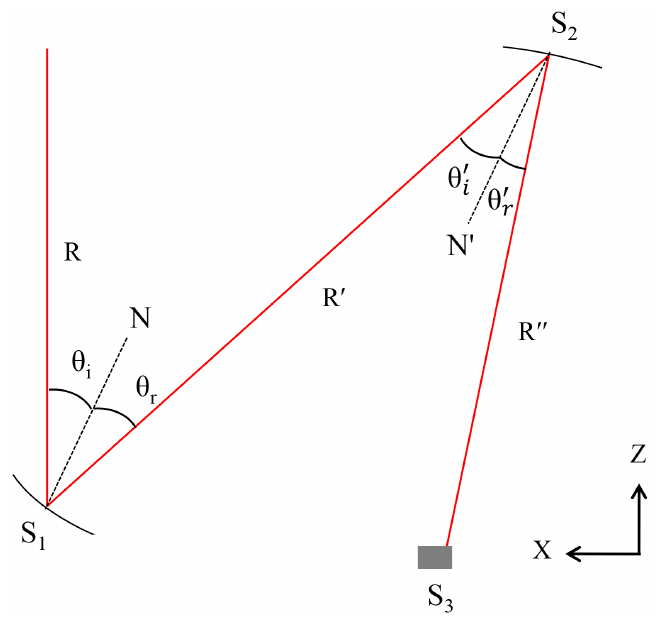
Figure 4. Two-dimensional geometry of the proposed two-stage CPV system.